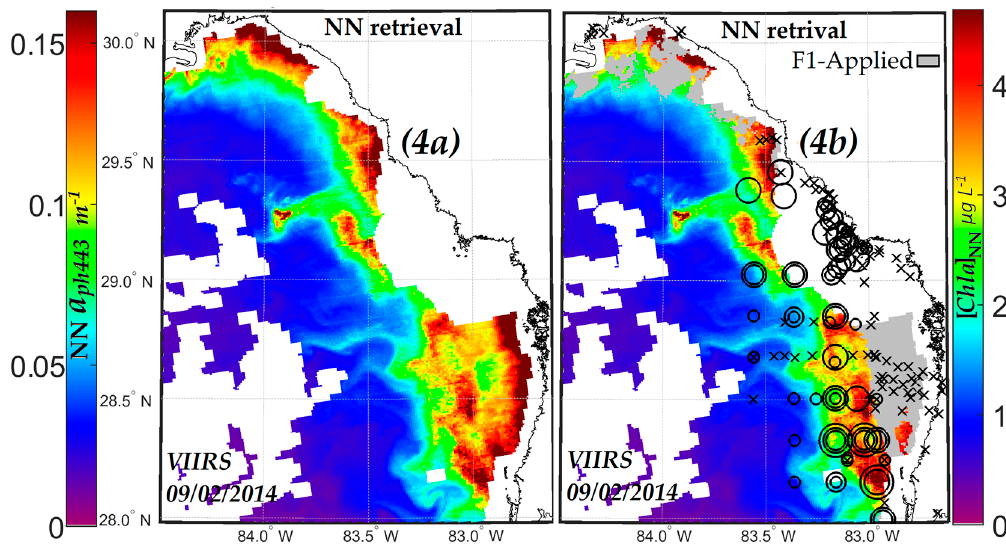
Figure 4. ( a ) Shows retrieved NN a ph 443 (left hand scale) and NN equiv. [ Chla ] (right hand scale); ( b ) Same image with F1 mask applied. Cell counts classifications same for Figures 2, 3a,b, and 4b. Dark gray represents F1 mask and white areas represent cloud cover or invalid data.